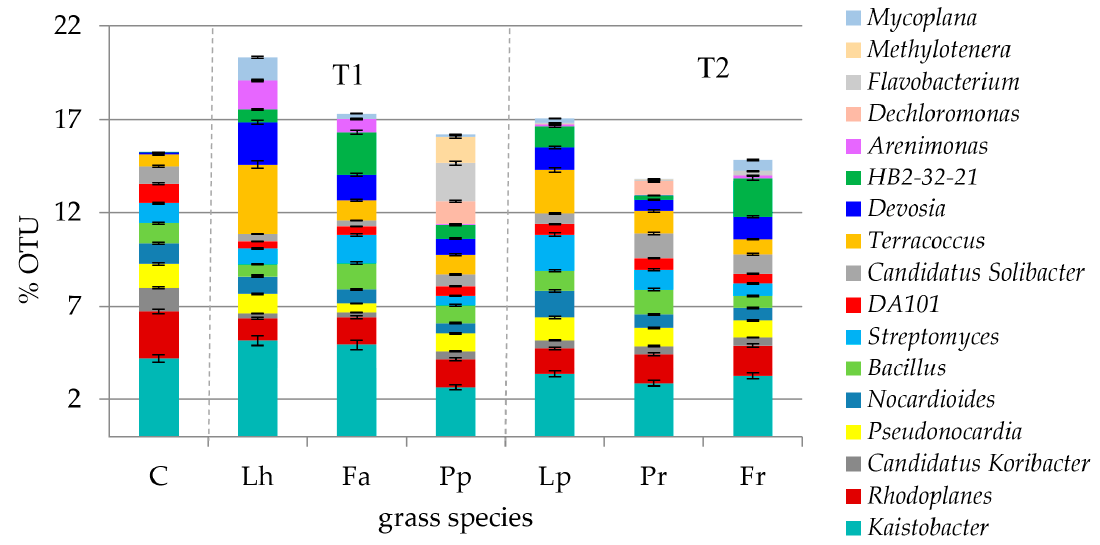
Figure 9. The operational taxonomic units (OTUs) structure of identified genus of bacteria in the total number of OTUs. C—unsown soil; T1—fodder grasses; T2—lawn grasses. Lh— Lolium x hybridum Hausskn; Fa— Festuca arundinacea ; Pp— Phleum pratense , Lp— Lolium perenne , Pr— Poa pratensis ; Fr— Festuca rubra. Table 4. Shannon and Simpson indices calculated from abundance of